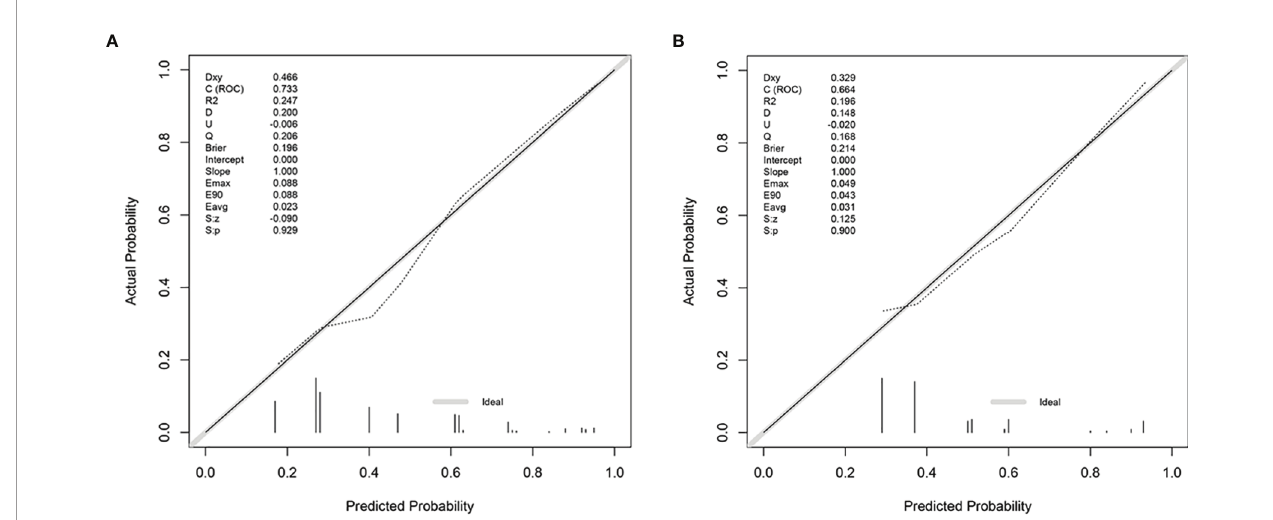
FIGURE 3 | Calibration curves for the nomogram for (A) training data set and (B) external validation data set. The calibration curves show a high degree of consistency between the predicted value and the actual situation, as the p-values are 0.5416304 (>0.1) and 0.5803292 (>0.1), respectively from the Hosmer- Lemeshow test.